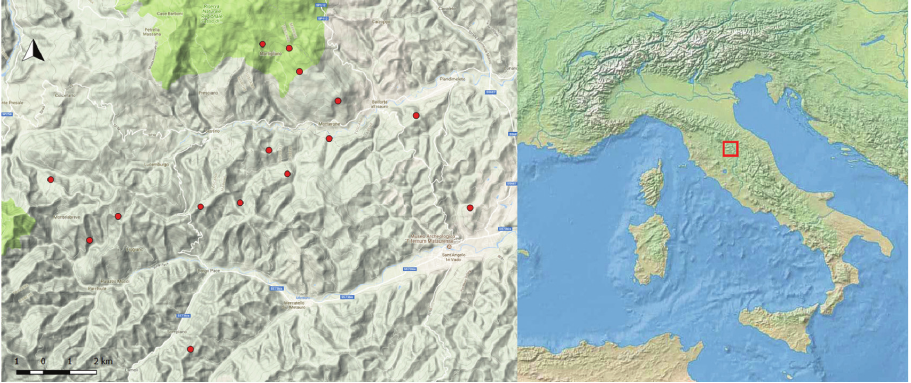
Figure 2. Geographic range and distribution map of Arceuthobium oxycedri in